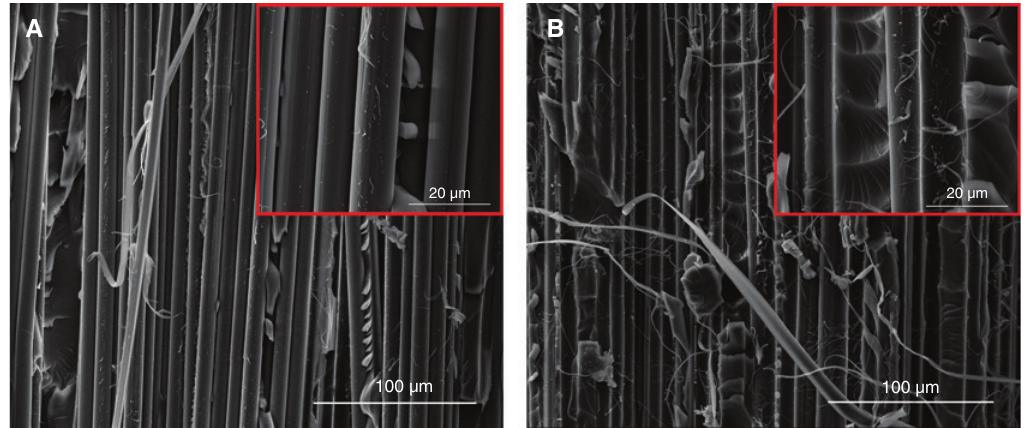
Figure 6: SEM images of the fractured PI/EP composites: (A) untreated, (B) treated 10